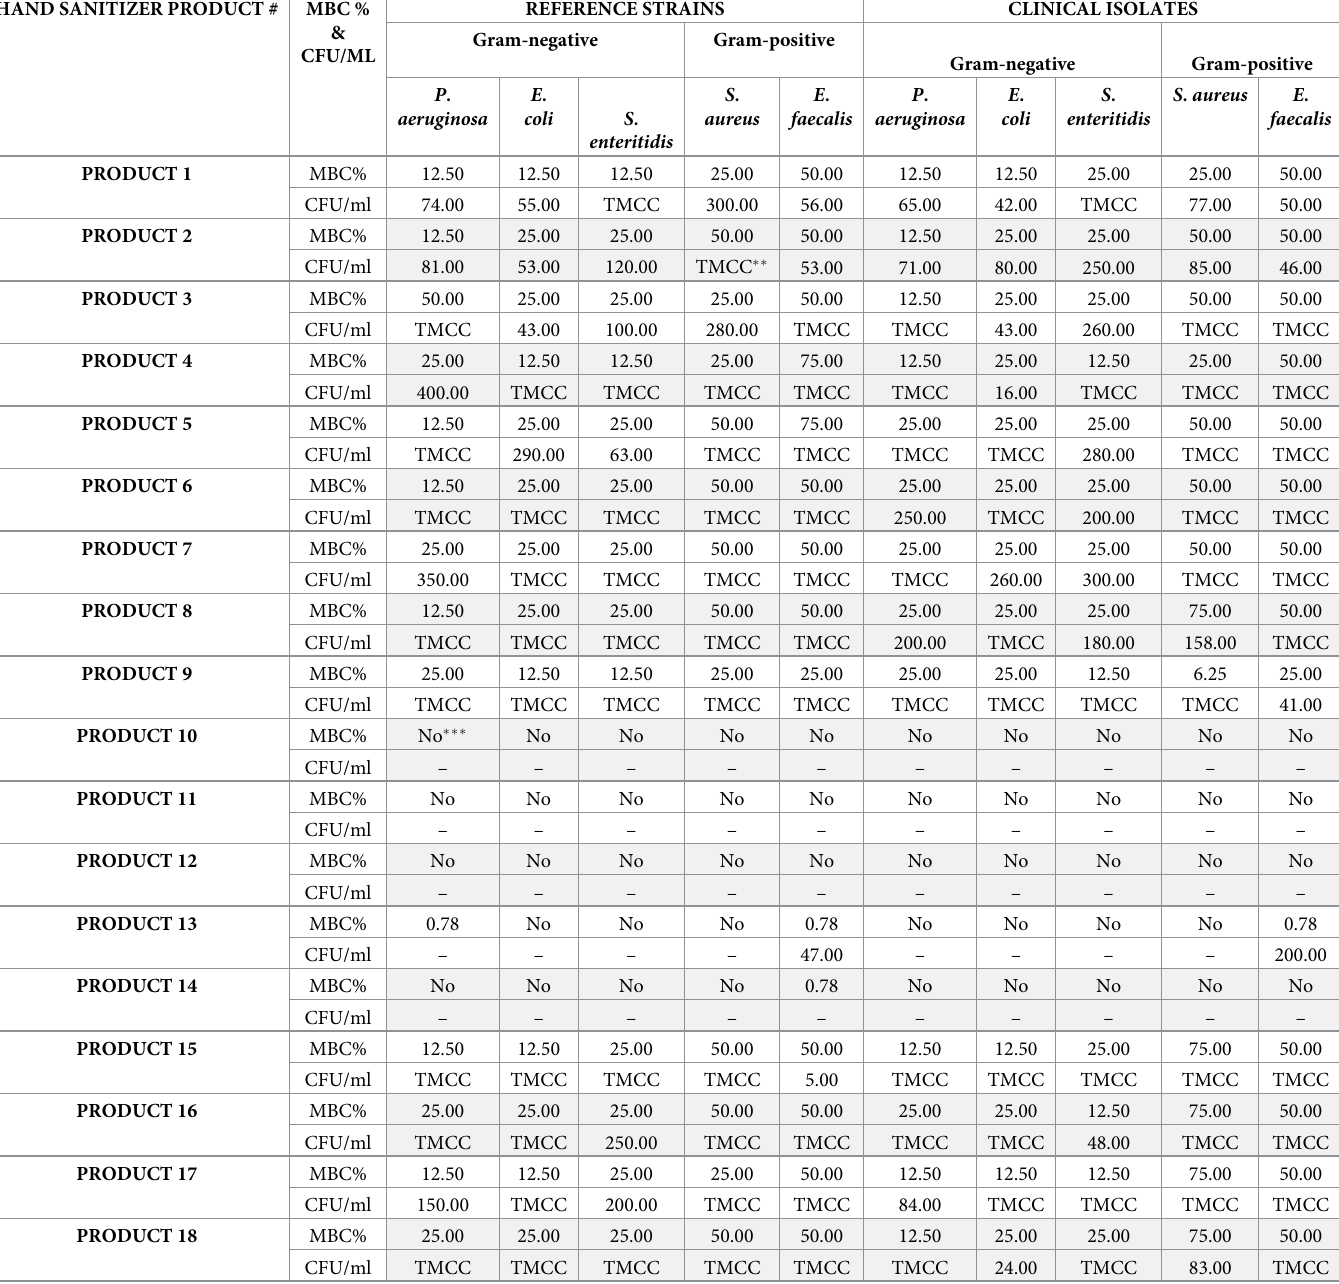
Table 3. This table demonstrates the MBC % and total number of bacterial colony of all isolates towards all disinfectant products �